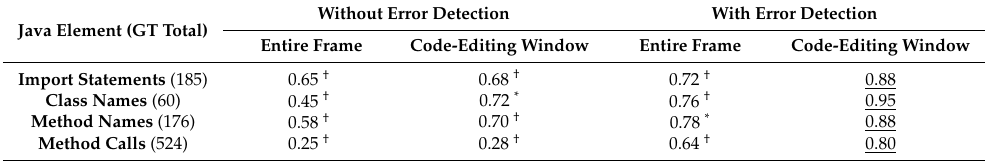
Table 6. The Jaccard index similarly between the set of the extracted Java elements from the entire frame and predicted code-editing window to that of the ground-truth annotation computed with and without error